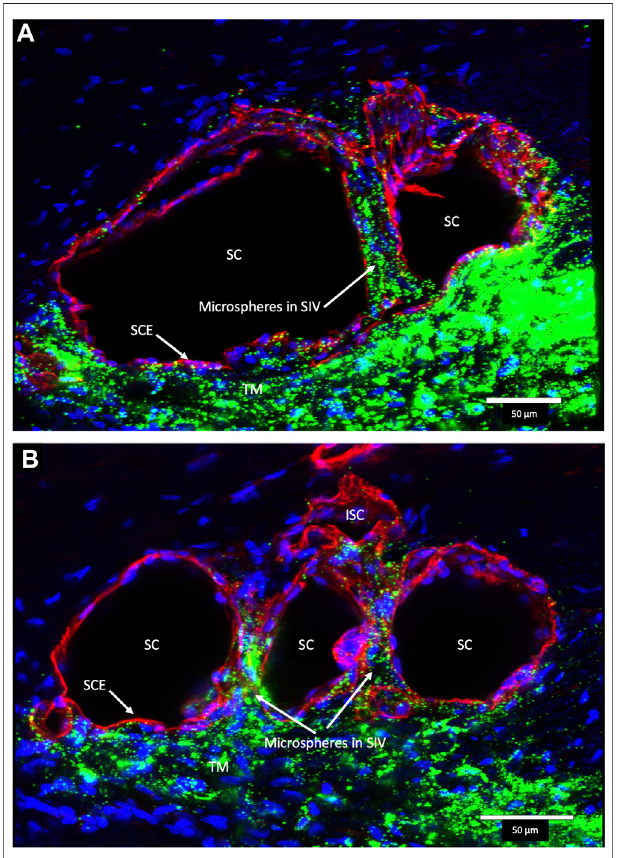
FIGURE 7 | Fluorescent microspheres in Schlemm ’ s canal inner wall valve-like structures. (A,B) Merged CD31 (red), DAPI (blue), and 500-nm fl uorescent microsphere (green) channels. (A) Stack size is 40 μ m and (B) is 43 µm. Schlemm ’ s canal (SC) inner wall endothelium forms a valve-like structure (SIV). The SIV arise from the SC inner wall endothelium (SCE) that forms the outer wall of the trabecular meshwork (TM). The funnel-shaped con fi guration extends into SC to form acylindrical conduit attaching to the SC external wall at collector channels (CCs). The TM is fi lled with fl uorescent microspheres. The microspheres fi ll the juxtacanalicular region with the SIV and the SIV connections with intrascleral channels (ISC) Supplementary Video S1 (A) #43LST12; (B) #43LIT4.